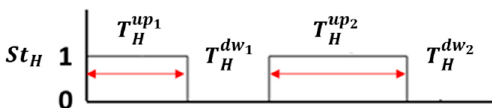
Figure 5. Chronological State Model of Hydropower Plant.